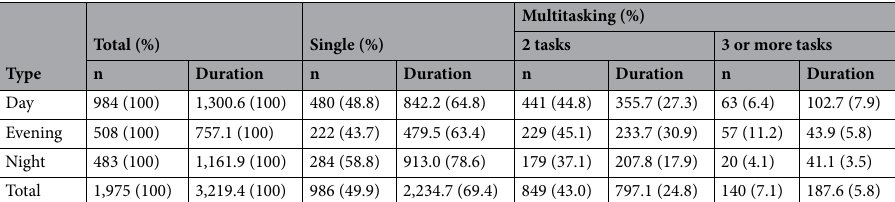
Table 2. Number and duration of nursing activities, per shift and 24-h period (N = 1,975). Duration is expressed in minutes.